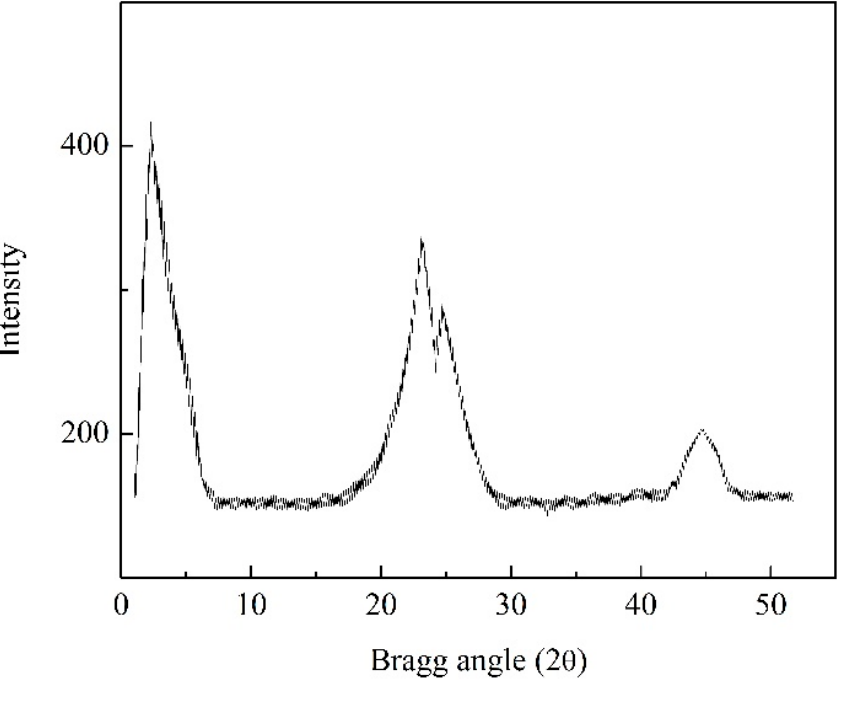
Figure 2. The X-ray diffraction pattern of the composite membrane.